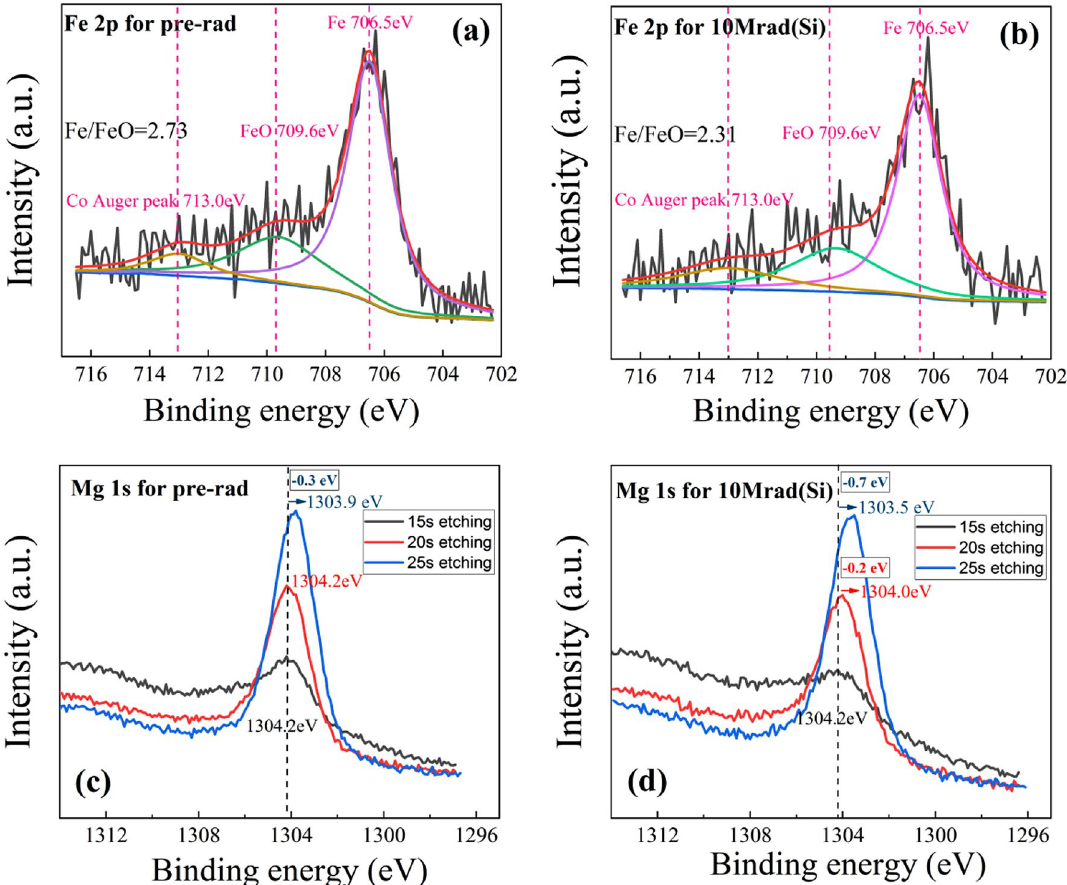
Figure 7. ( a ) Fe 2p XPS spectrum before X-ray radiation, ( b ) Fe 2p XPS spectrum after radiation with 10 Mrad(Si) total ionizing dose, ( c ) Mg 1 s XPS spectra before X-ray radiation at different etching times, and ( d ) Mg 1 s XPS spectra after 10 Mrad(Si) radiation at different etching time. Fe XPS spectra are detected from the CoFeB/ MgO interface in the Ta/CoFeB/MgO/Ta film. Mg XPS spectra are detected from the top of the MgO layer to the CoFeB/ MgO interface in the Ta/CoFeB/MgO/Ta